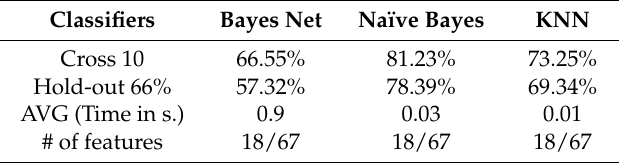
Table 2. Results using geometrical features for Secure Password DB